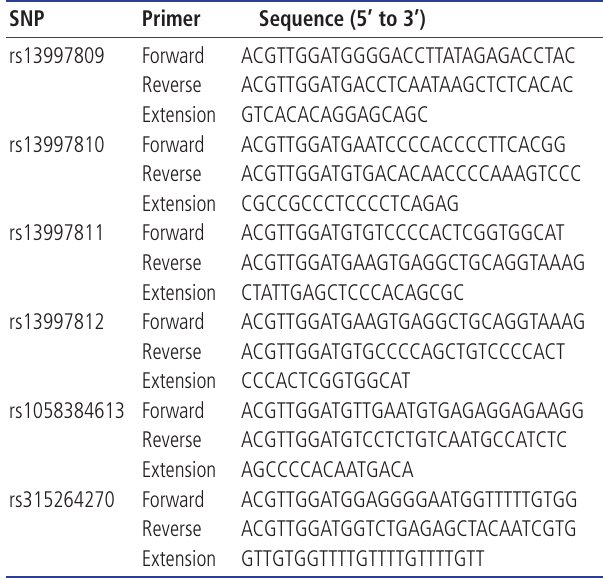
Table 2. Primer sequences used in genotyping for the UCP3